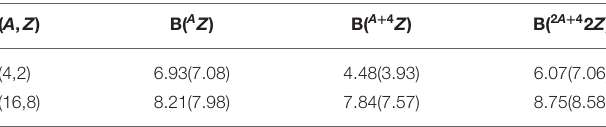
TABLE 2 | Self-binding energies of the ground states [7] are calculated using the SV-bas effective nuclear force.